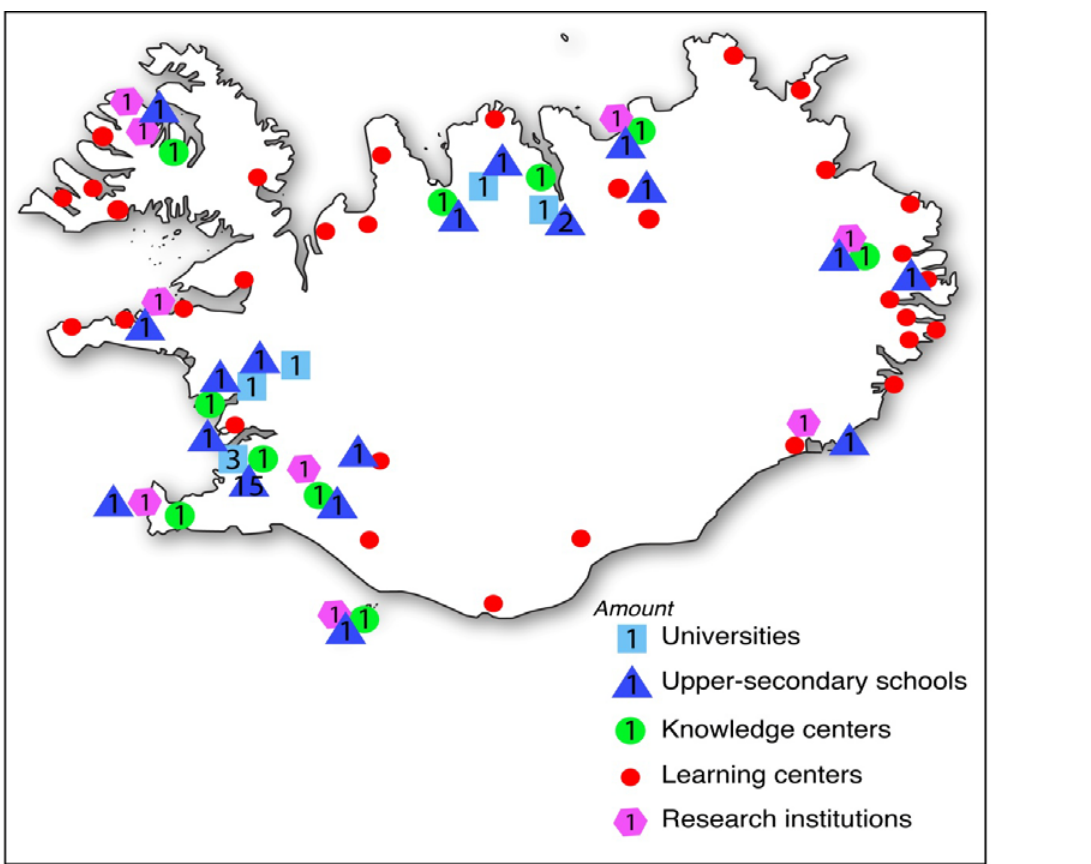
Figure 1 . Knowledge centres, learning centres, universities, and upper-secondary schools in Iceland,